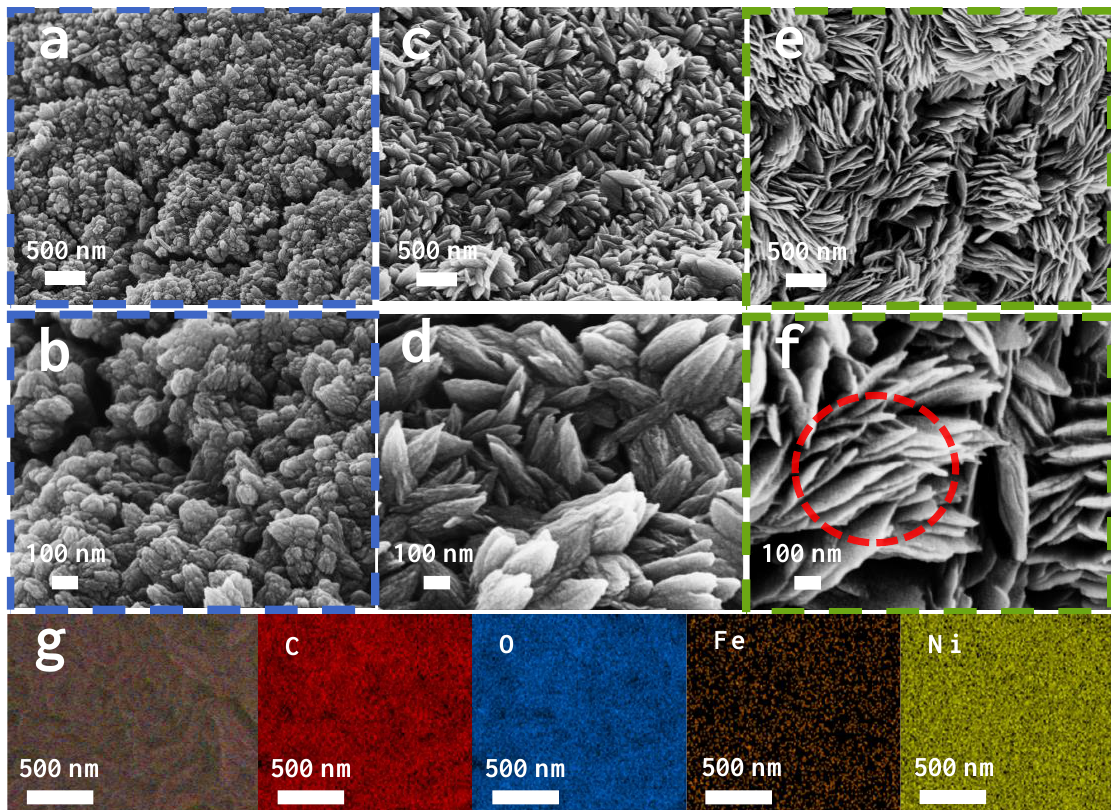
Figure 2. Morphology characterization: SEM images of ( a , b ) NiFe-MOF-4; ( c , d ) NiFe-MOF-8; ( e , f ) NiFe-MOF-12 at various multiples; ( g ) the elemental mapping pictures of NiFe-MOF-8.